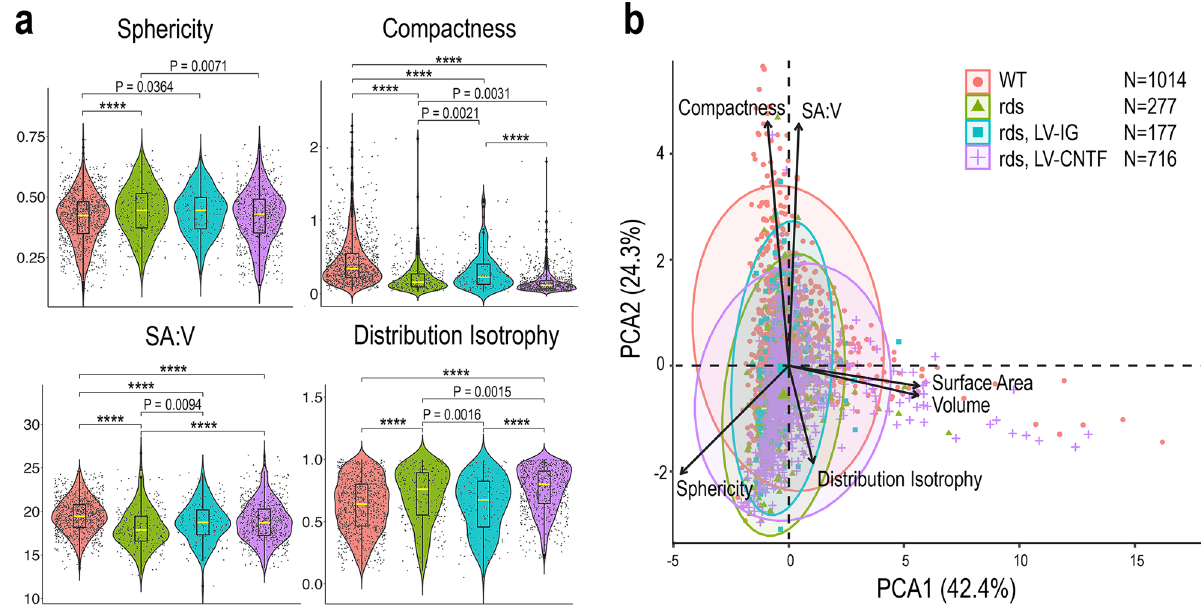
Fig. 2 | Characterization of rod photoreceptor mitochondrial morphological features. a Quanti fi cation of PhAM-labeled mitochondria in rod inner segments capturedwithSIMinWT,rds,andrdsretinas( N =3)treatedwithLV-IGorLV-CNTF. Violin plots show geometrical features of the individual mitochondrion, including sphericity, compactness, ratio of surface area to volume (SA:V), and distribution isotropy.Dotsrepresentindividualmitochondriadatapoints.Boxesrepresent50% of the mitochondria, and yellow lines represent median values. The horizontal boundsoftheboxindicate25thand75thpercentiles.Thelowerwhiskerscomprise